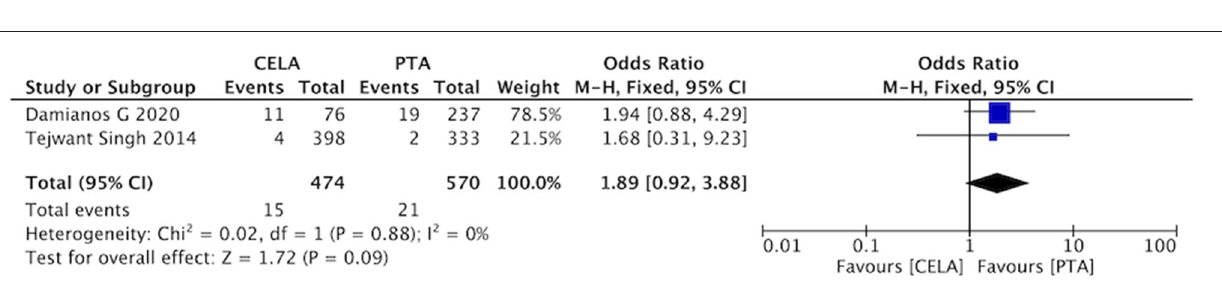
between CELA group and the PTA group (OR 1.11, 95% CI 0.58-2.10, P = 0.0001) using a random effects model (I 2 = 83%, P = 0.75) ( Figure 9